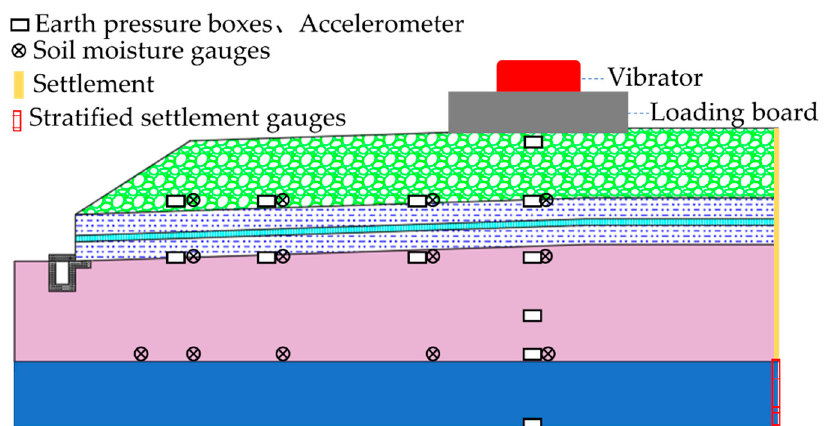
Figure 8. Sensor arrangement diagram.